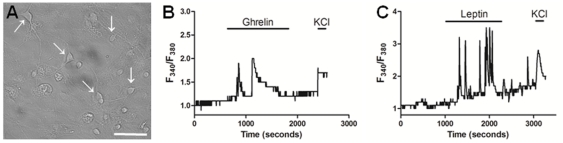
Hypothalamic neurospheres-derived neurons respond to ghrelin and leptin.(A) Phase-contrast images of hypothalamic neurons (arrows) obtained from plated neurospheres after 18 days in differentiation conditions. Representative recordings of intracellular calcium concentrations ([Ca2+]i) of hypothalamic cells responding to (B) Ghrelin (10−10 M) or (C) Leptin (10−12 M) followed by to 50 mM KCl depolarization. Scale bar: 50 µm.